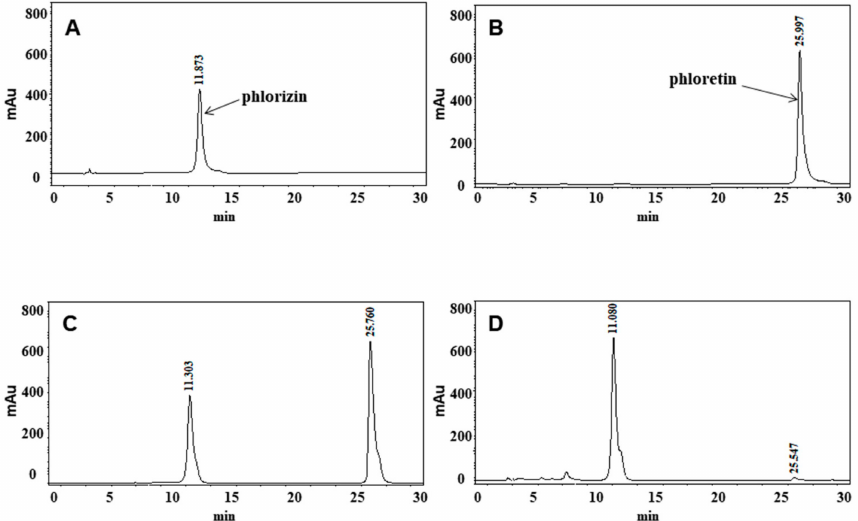
Figure 1. HPLC chromatogram of phlorizin ( A ). HPLC chromatogram of phloretin ( B ). HPLC chromatogram of phlorizin and phloretin ( C ). HPLC chromatogram of M.toringoides extract ( D